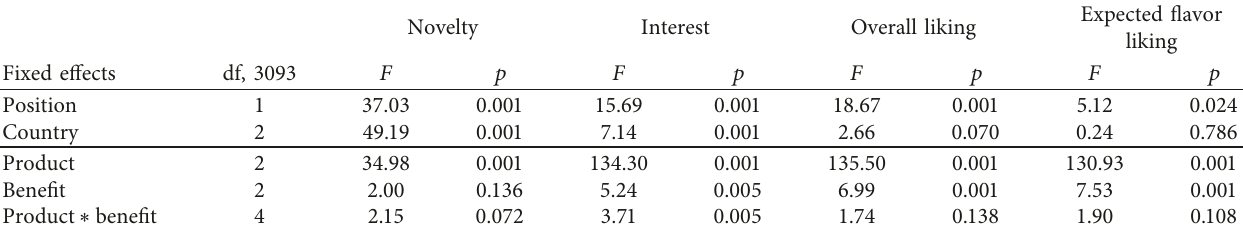
Table 3: Novelty, interest, overall liking, and expected flavor liking as a function of experimental factors product and benefits controlled for position (presentation order) and country